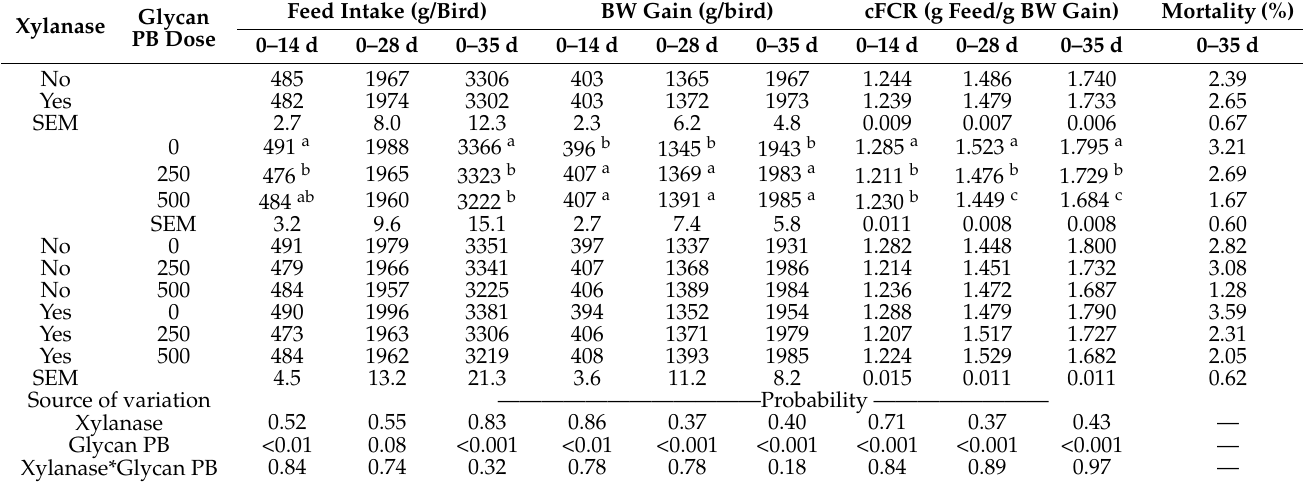
Table 3. Effects of a precision biotic (Glycan PB) ingredient 1 supplemented at different doses in feed without or with the inclusion of a xylanase enzyme on the growth performance and mortality of broiler chickens raised in floor pens (Trial 1).